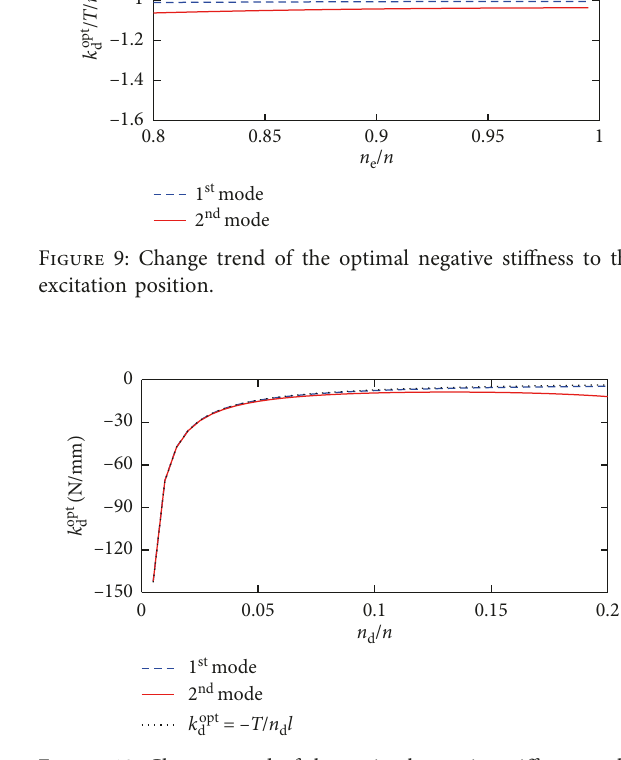
Figure 10: Change trend of the optimal negative stiffness to the damper